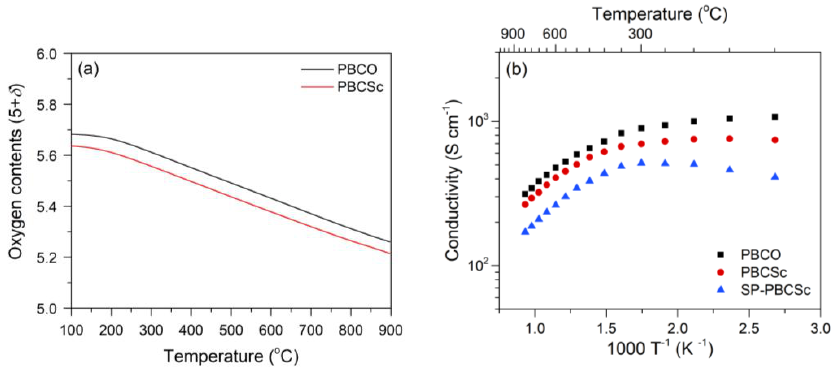
Figure 3. ( a ) Thermogravimetric analysis (TGA) and ( b ) electrical conductivity for the samples as a function of temperature in air.